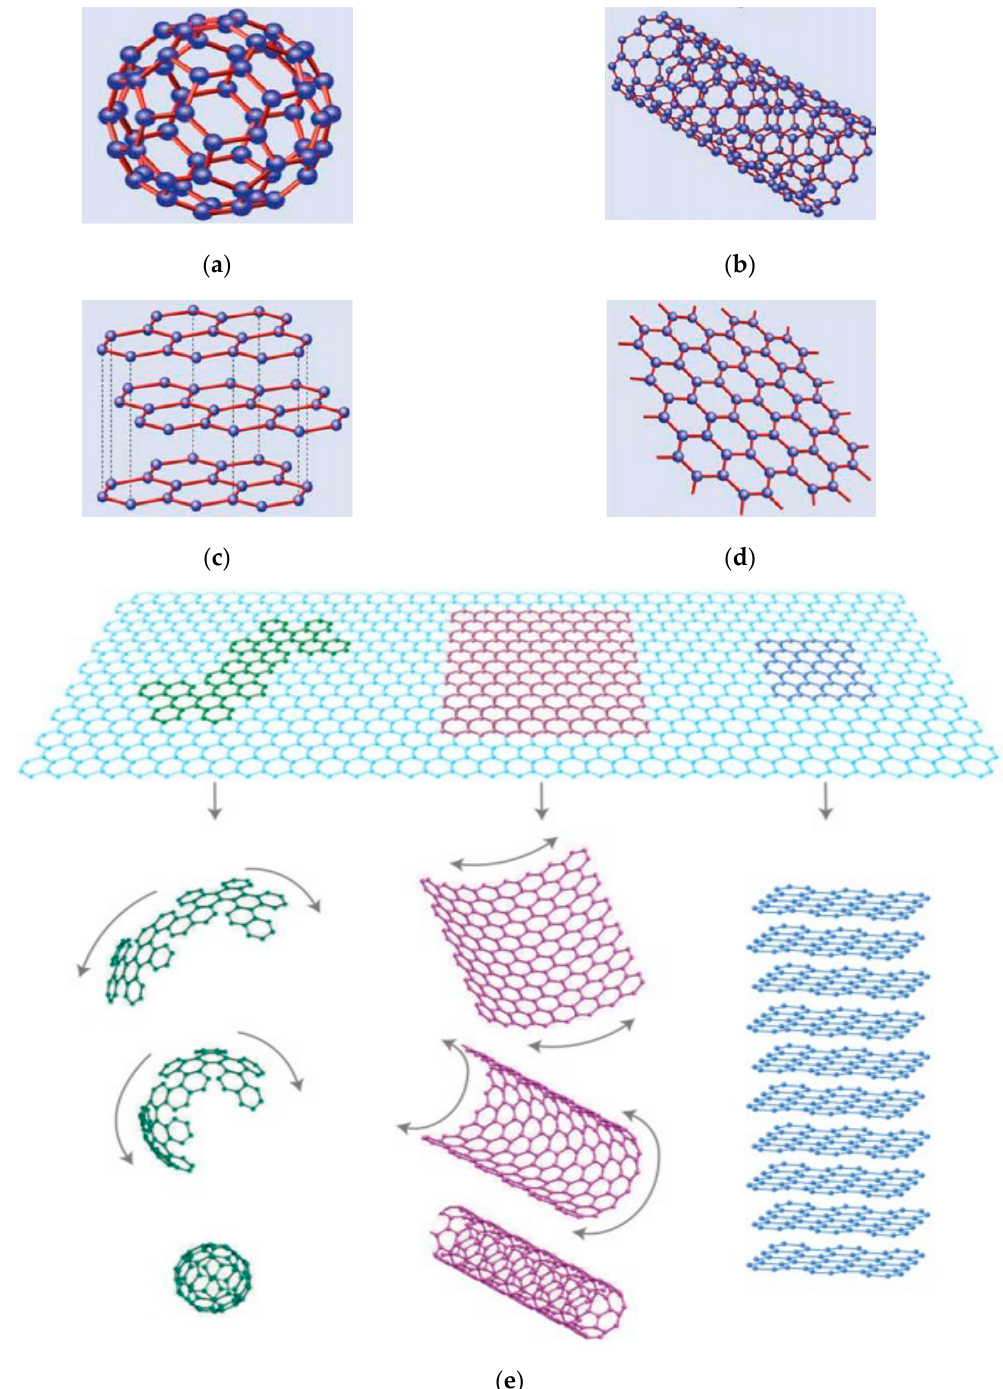
Figure 2. Various structural form of graphene; ( a ) wrapped honeycomb structure of zero-dimensional graphene nanoparticle; ( b ) Rolled honeycomb structure forms of one-dimensional graphene; ( c ) single planar two-dimensional graphene sheet; ( d ) stacked honeycomb structure of three-dimensional graphite, and ( e ) extraction of various structural forms from 2D graphene sheet. Modified from [39,40], Elsevier, 2010.